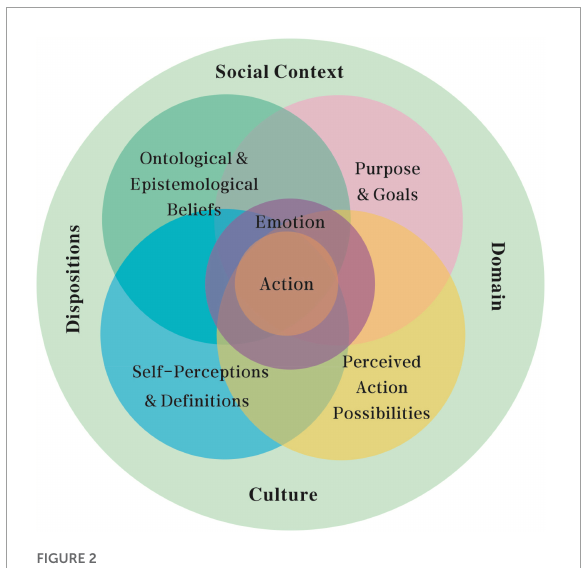
FIGURE2 The dynamic systems model of role identity (DSMRI) (Kaplan and Garner, 2017, 2018; Garner and Kaplan,